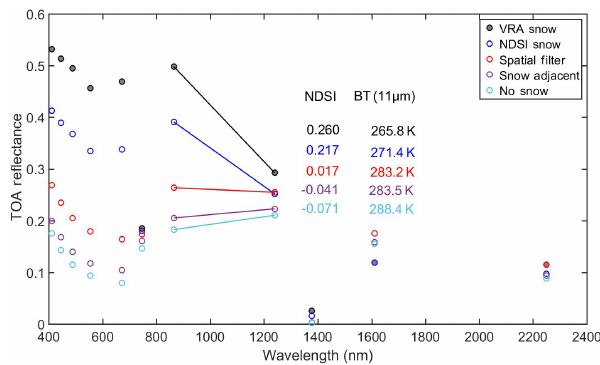
Figure 3. Spectral curve of the TOA reflectance at 11 VIIRS wave- lengths in five populations of pixels selected based on internal